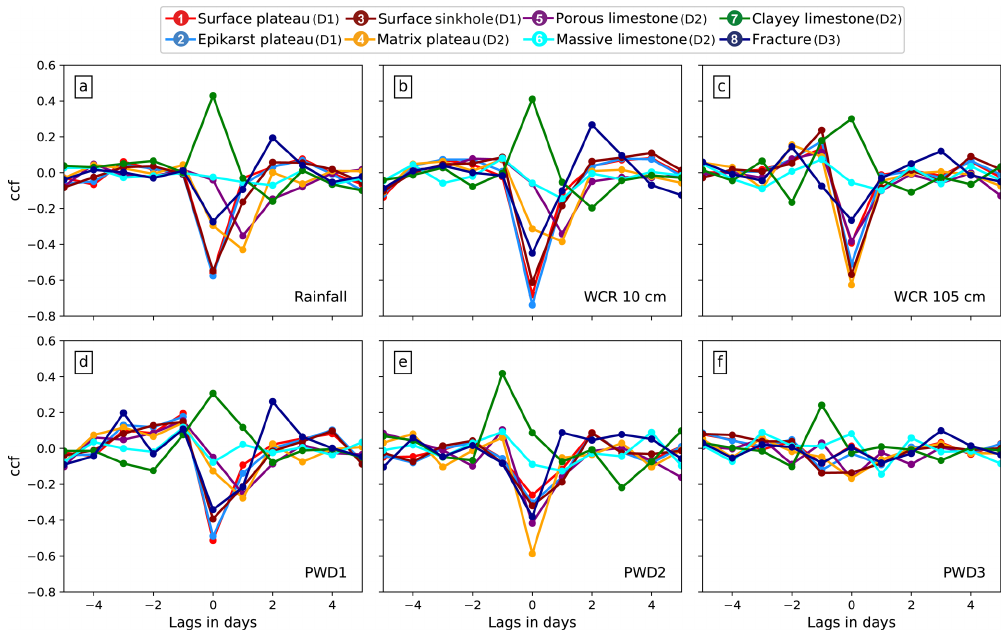
Figure 14. Cross-correlation of the ERT data sets of the eight regions defined in Fig. 7 and environmental data